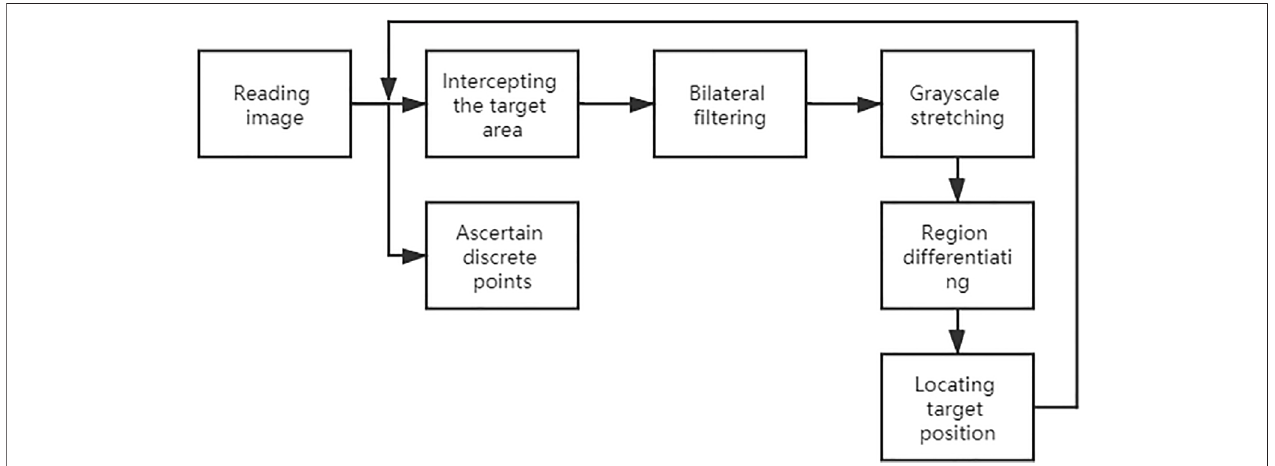
FIGURE 6 | Flow chart of the improved inter-frame difference method.